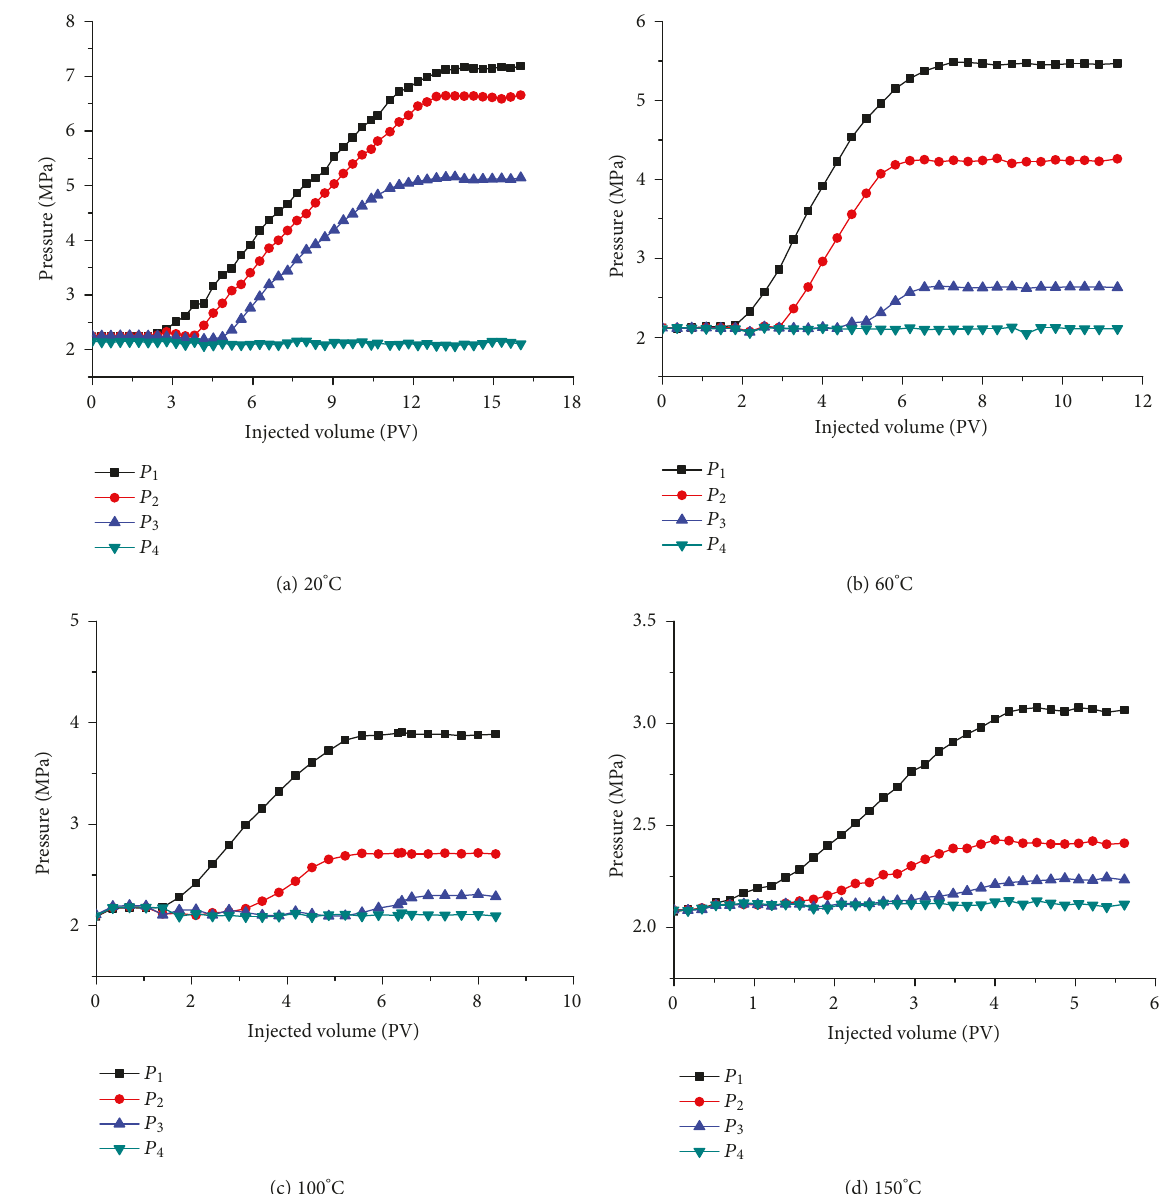
Figure 4: Change of fl owing pressure with injected volume at di ff erent